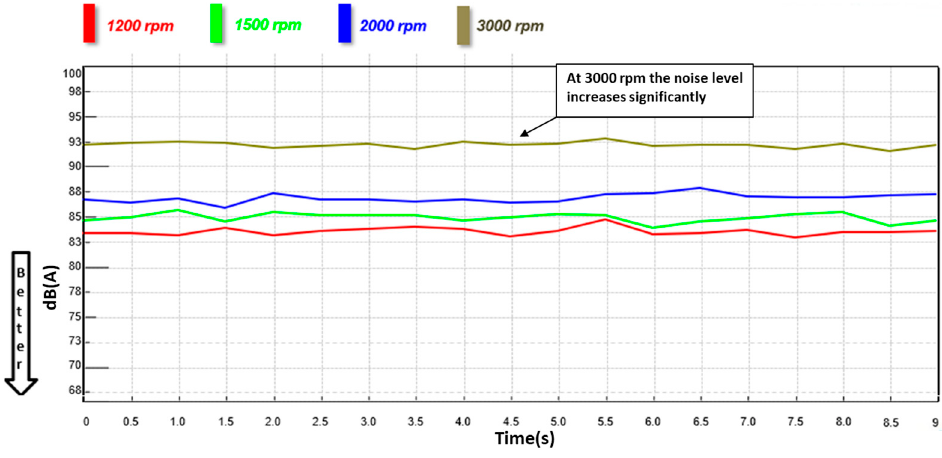
Figure 4. Engine right-side noise level at constant rpm.